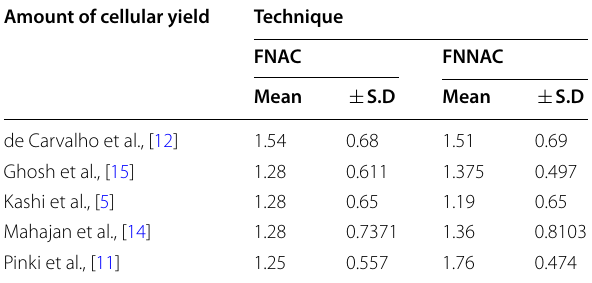
Table 10 comparison between different studies regarding amount of cellular yield using FNAC vs FNNAC [10] Amount of cellular yield